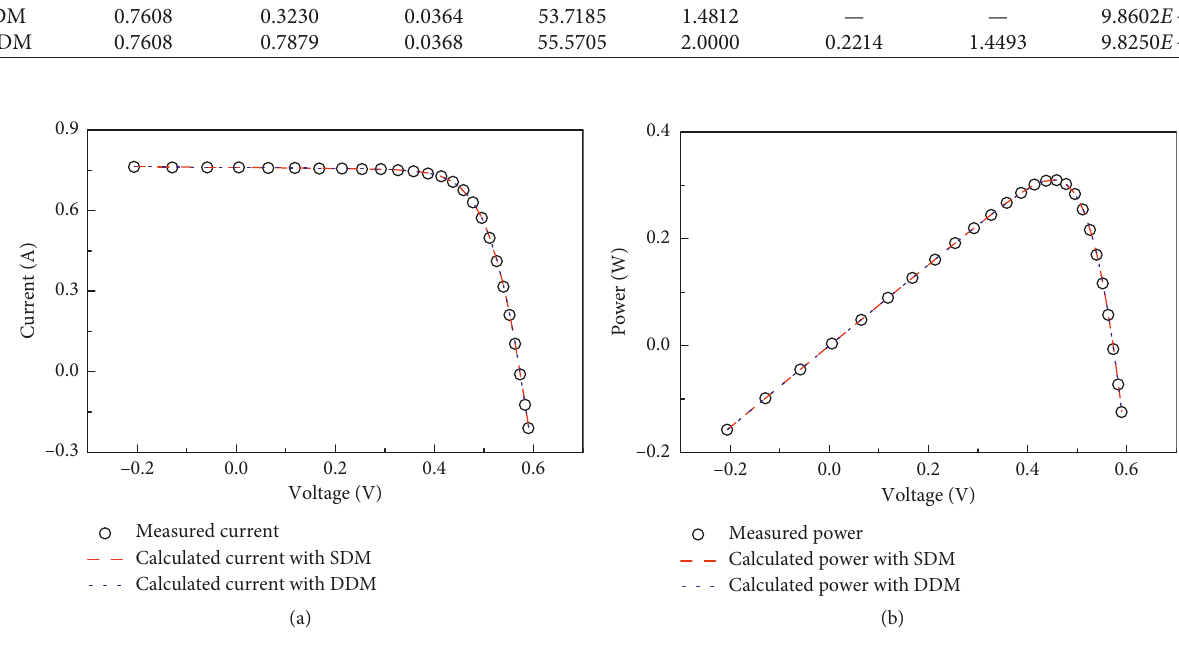
Figure 6: Comparison between the measured and calculated data achieved by SDO for the RTC France silicon solar cell. (a) I-V characteristic; (b) P-V characteristic. Table 5: Calculated results for the RTC France solar cell by SDO.